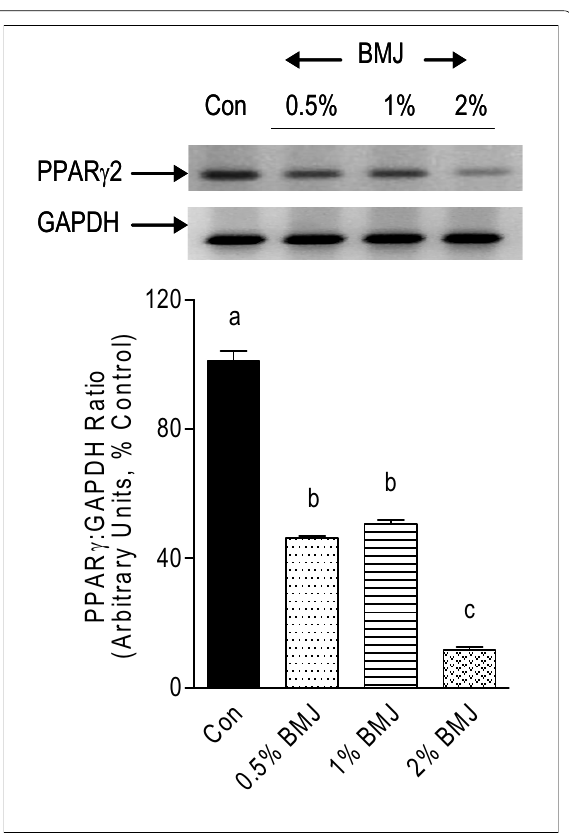
Figure 4 Effect of bitter melon juice on PPARγ mRNA expression . Differentiating preadipocytes treated with varying concentrations of BMJ demonstrate a significant reduction in PPARγ mRNA gene expres- sion. Bar graphs depict the densitometry scans of PPARγ amplicons (348-bp) and are expressed as a ratio to GAPDH amplicon (298-bp) in- tensity. Data are expressed as a percentage of the control (set as 100%) and the values represent the mean ± SE (n = 6) of three independent experiments analyzed in duplicate. a, b, c Mean values with common let- ters do not differ (p <